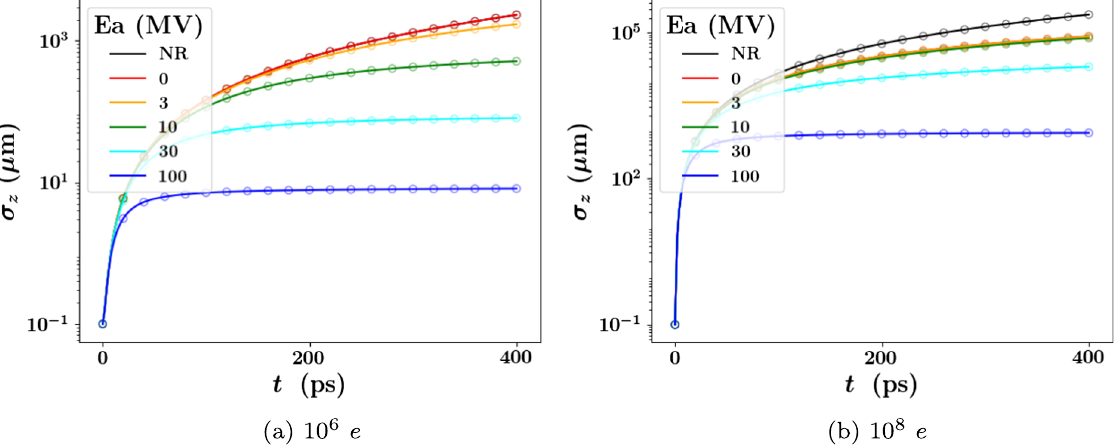
FIG. 14. Theoretical predictions (solid line) and M -shell simulations (hollow dots) of the width of an evolving planar-symmetric initially Gaussian distribution for two experiment relevant regimes. Both cases assumed a geometry of transverse width of 100 μ m and longitudinal width of 0 . 1 μ m, and they differed in the number of electrons in the bunch: (a) 10 6 e corresponding to an E ≈ 3 MV. Notice that the y-axis is logarithmic, and the scales are different between the two plots. Also (b) 10 8 e corresponding to an E T 1 notice that relativistic effects of spreading of the bunch in the absence of an accelerating field within this timescale are not significant for the 10 6 case but noticeable for the 10 8 case. Furthermore, the accelerating field effect is noticeable within this timescale when 10 MV for 10 6 and E 30 MV for 10 8 ; however, notice that in the 10 8 case, the longitudinal beam width is larger than the E a ¼ a ¼ transverse width and that the 1 D model is probably no longer a valid